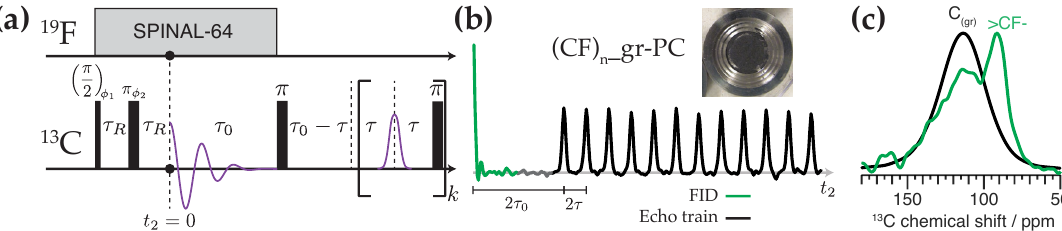
Figure 2. Direct excitation CPMG NMR for enhancement of 13 C in spin-sparse domains: ( a ) pulse sequence, ( b ) experimental 13 C MAS NMR time domain signal (real part) from (CF) n _gr-PC up to the twelfth echo (of thirty thousand), showing the FID (green) and echo train (black), ( c ) frequency domain 13 C MAS NMR spectrum of (CF) n _gr-PC using the FID (green) or the matched reconstructed echo (black). For the experimental data k = 30,000, τ R = 60 µ s, τ 0 = 2.4 ms, and τ = 0.6 ms. The τ R , τ 0 , and τ intervals are measured with respect to the dashed lines or the center of the π pulses. Nested cycling of φ 1 and φ 2 selects two p I symmetry pathways [32] prior to CPMG: { 0 → + 1 → − 1 } and { 0 → − 1 → + 1 } . Both time and frequency domain spectra have been apodized to improve presentation. The pulse sequence is available in the Supplementary